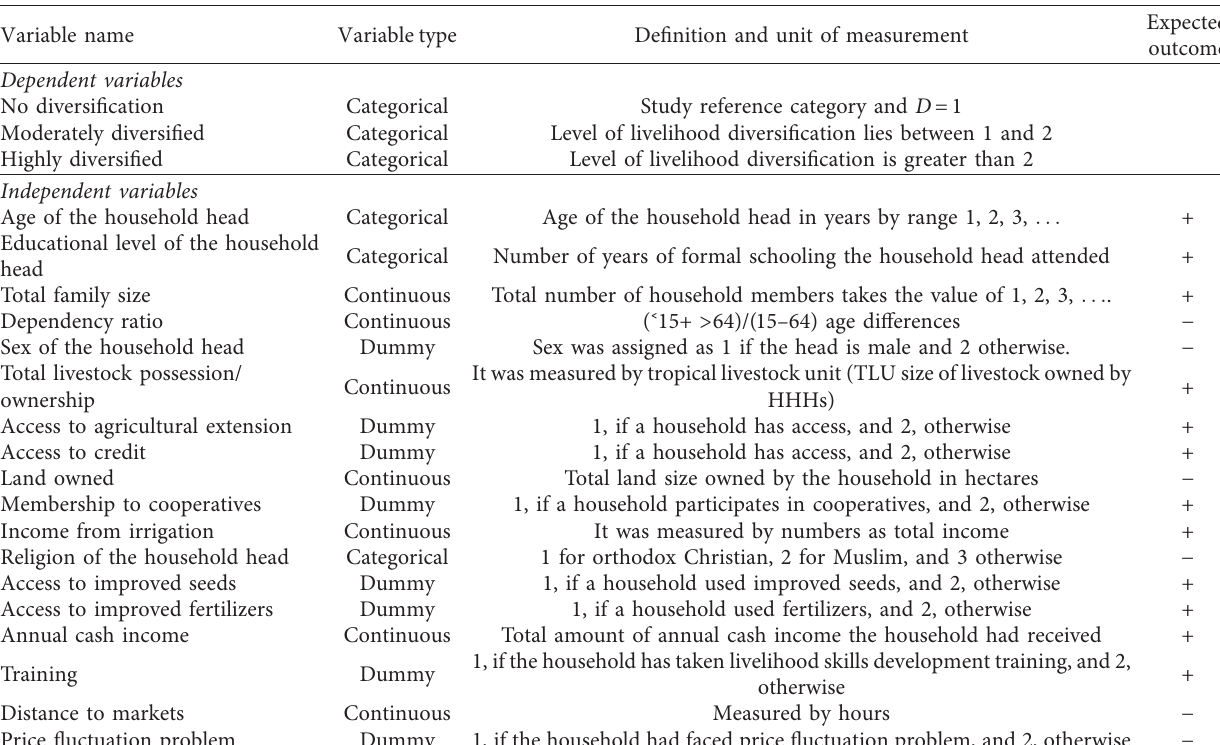
Table 1: Study variables, multinomial logit model, and